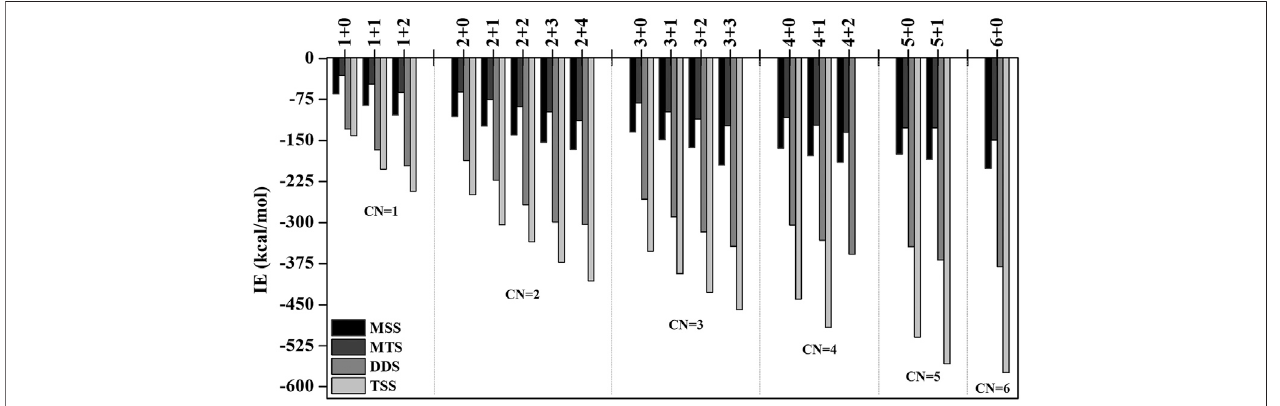
FIGURE 9 | Variation of interaction energy (IE in kcal/mol) with the increase in coordination number (CN) of the monocationic singlet state (MSS) and triplet state (MTS),dicationicdoubletstate(DDS),andtricationicsingletstate(TSS)oftheScioninSc z+ (OH